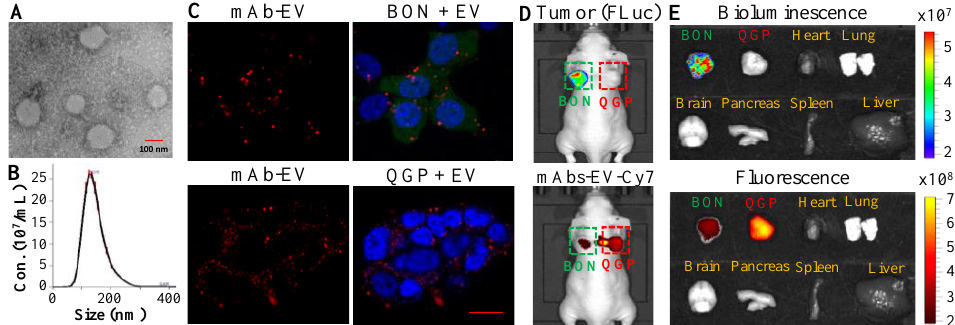
Figure 2. Evaluation of the NET-specific targeting of the SSTR2 / CXCR4 dual-targeted monoclonal antibodies tagged extracellular vesicle (mAbs-EV). ( A ) Transmission electron microscope (TEM) image of mAbs-EV. ( B ) Size distribution analysis by NanoSight. ( C ) Live-cell confocal laser scanning microscopy (CLSM) dynamic imaging of QGP and BON cells mixed with mAbs-EV-Liss Rhod. Two or three-color CLSM: whole cell labeled with green fluorescent protein (GFP) (displayed as green), nucleus labeled with 4′,6-diamidino-2-phenylindole ( DAPI) (displayed as blue), and mAbs-EV with Liss Rhod (displayed as red). Scale bar equals 10 µm. ( D ) In vivo live-animal In Vivo Imaging System (IVIS) imaging to analyze cancer specific targeting and biodistribution of mAbs-EV-AAV 24 h postinjection in NET xenograft mouse model ( n = 4). ( E ) Ex vivo IVIS imaging of tumor and important organs 24 h postinjection.